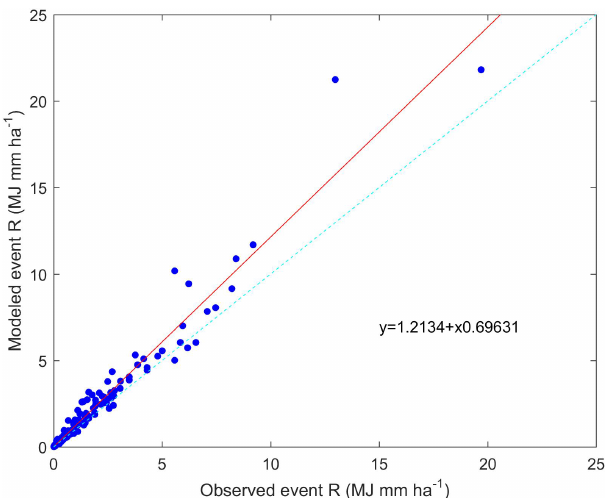
Figure 5. Comparison of observed and modelled event rainfall ero- sivity at Bristol Station, covering the period of 2016–2019.